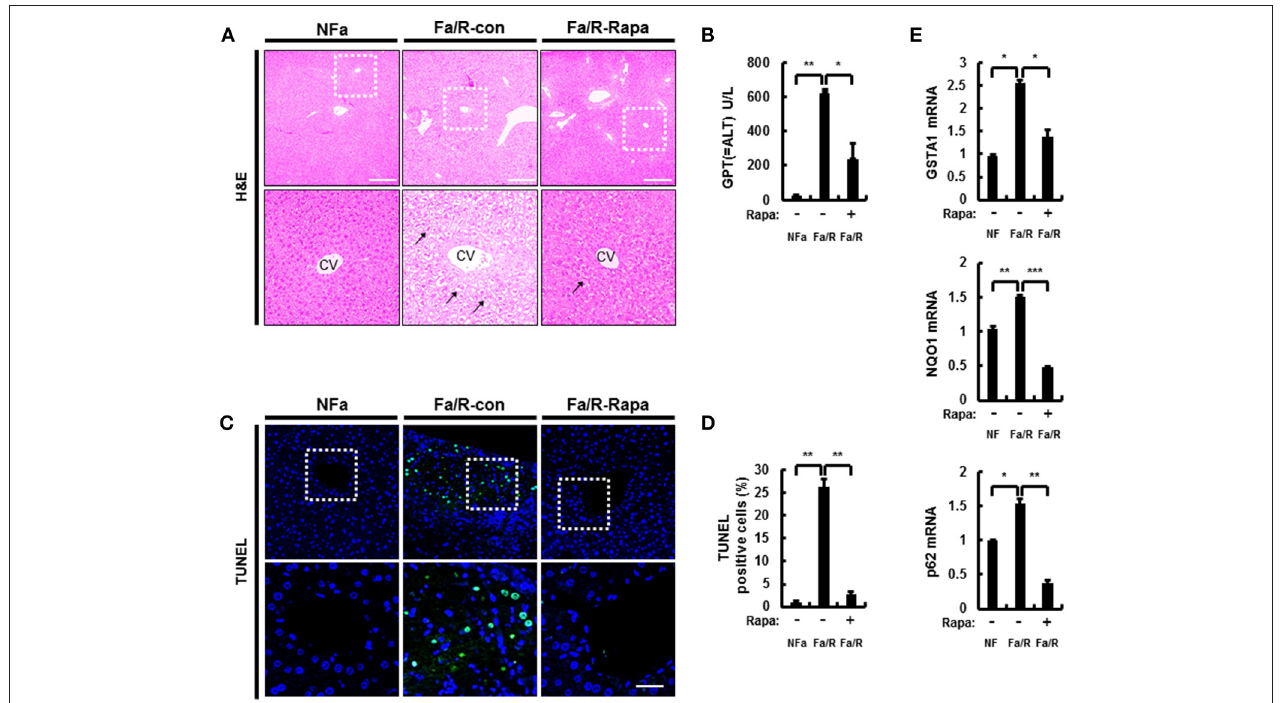
FIGURE 6 | Inhibition of mTORC1 protects mice against acute lipogenic stimulus-mediated liver injury in mice. (A–E) Mice were maintained in a non-fasted state (NFa) ( n = 4) or fasted overnight and then refed a high-carbohydrate, fat-free diet (Fa/R) with vehicle ( n = 4) or rapamycin ( n = 4). (A) The liver sections from mice were stained by using H&E. The extent of ballooning degeneration (arrow) is indicated on the bottom right set of images. CV, central vein. Scale bar = 200 µ m. (B) The serum alanine aminotransferase (ALT) concentration was measured in each group of mice. (C) Images for TUNEL analysis of liver sections from each three groups of mice. Scale bar = 100 µ m. (D) Quantitative graph of the TUNEL images of the liver sections. The data are the mean ± standard error for eight or nine mice of each group. * p < 0.05 and ** p < 0.01. (E) Total RNA isolated from liver was subjected to qRT-PCR analysis of GSTA1 (top), NQO1 (middle), and p62 (bottom) mRNAs. The data are presented relative to the corresponding value for non-fasted mice and are the mean ± standard error for eight or nine mice in each group. * p < 0.05, ** p < 0.01, and *** p <